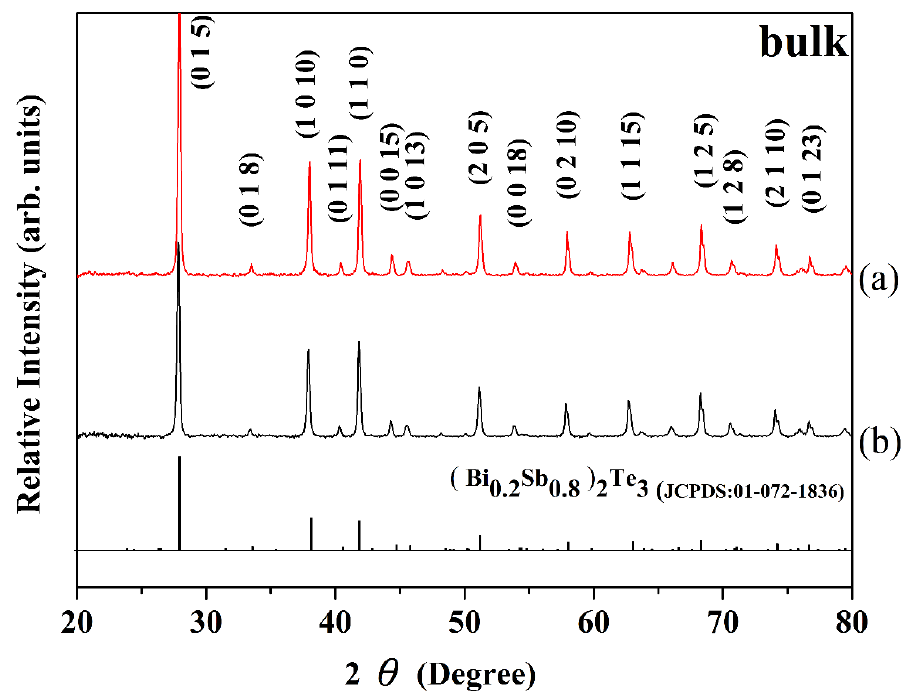
Figure 2. XRD patterns of γ -Al 2 O 3 -doped Bi 0.4 Sb 1.6 Te 3 bulk specimens. ( a ) 1 wt % Al 2 O 3 ; ( b ) 3 wt % Al 2 O 3 .